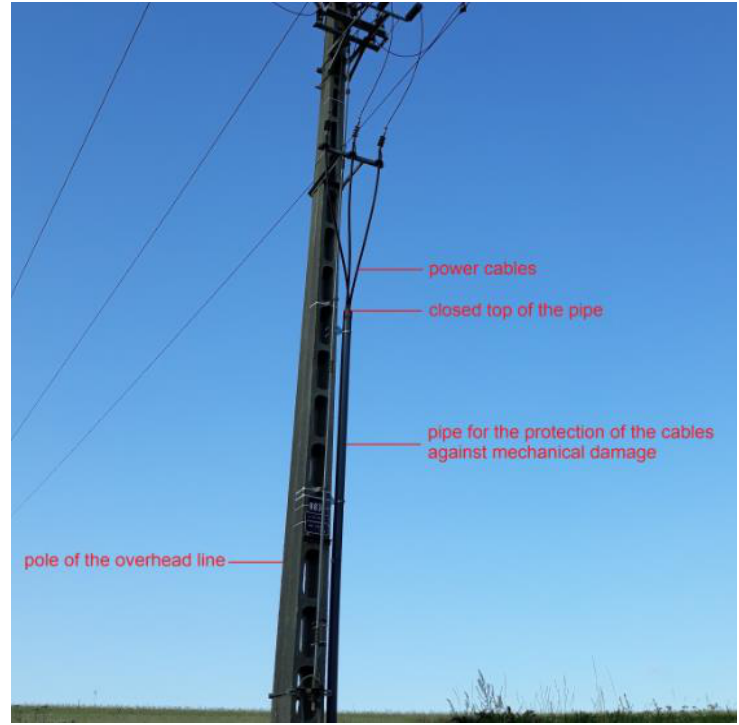
Figure 12. A pole of the overhead line with cables inside the pipe used for the protection of cables against mechanical damage.